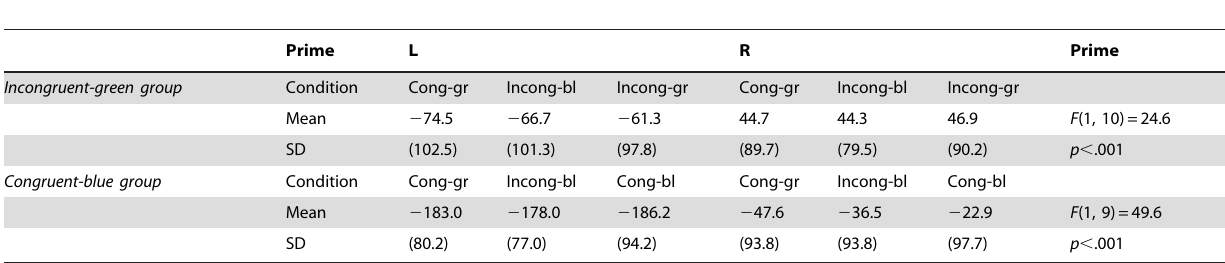
Table 2. Mean velocity of the 100-ms-time window in each condition of incongruent-green and congruent-blue groups in the test